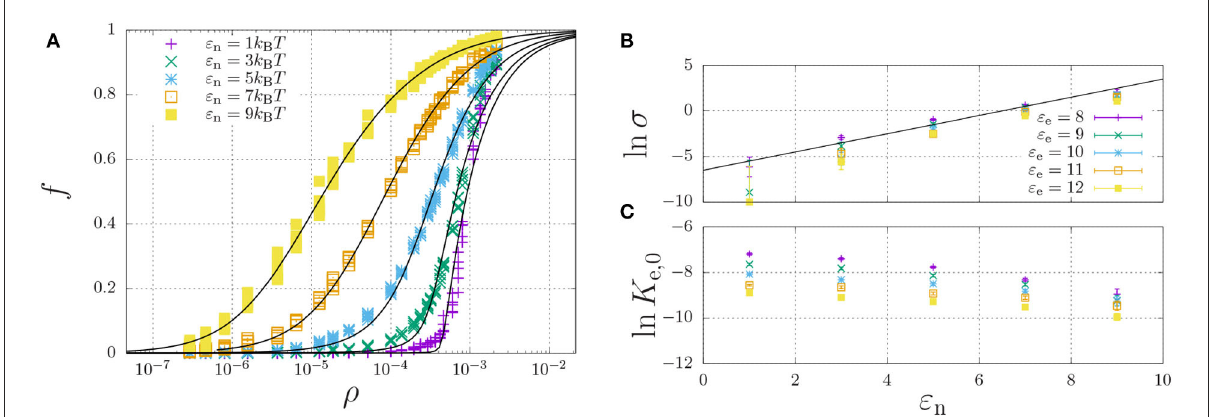
FIGURE6 Self-assembly of a hydrophilic chain ( ε H 0) for a fixed elongation energy ε e 9 k B T and varying dimerisation energy ε n . (A) The fraction of = = aggregated material is plotted against the concentration. For each value of ε n , the data was curve-fitted using Equation (11) with cooperativity K e,0 exp( ε e ) (C) as fitting parameters. For (B,C) , each point represents the mean and standard error factor σ (B) and the equilibrium constant K e = of 5